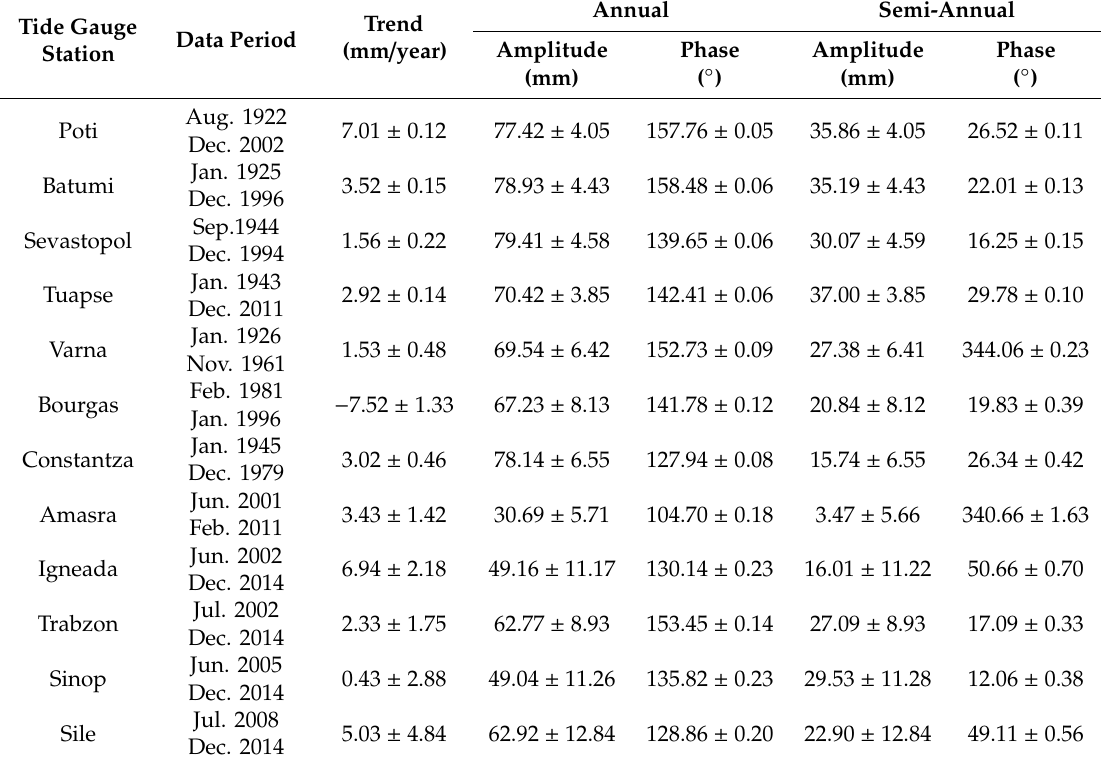
Table 2. Trend and seasonal components of coastal (relative) sea level changes at the tide gauge stations along the Black Sea coast (the longest available data periods of the tide gauges were used for the